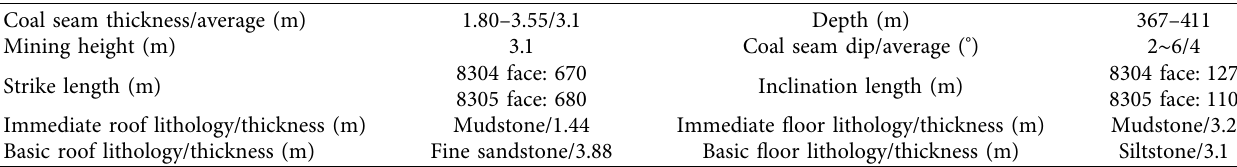
Figure 5: Plane and roof lithology column of 8304 and 8305 working face. (a) Working face plan. (b) Roof lithology column. Table 1: Basic parameters of 8304 and 8305 working face.